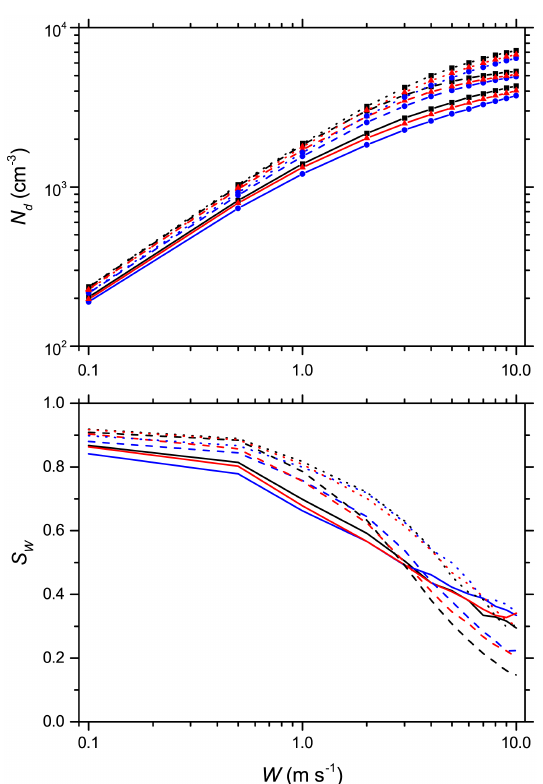
Figure 3. Number of particles activated (top) and sensitivity S W of N d to the updraft velocity W (bottom) for κ p the MP 5 , 1 (solid line), MP 1 , 5 (dashed line) and HP 5 , 5 (dotted line) case studies. Results for internal mixed Int population and exter- nally mixed populations Ext 1 and Ext 2 are in black, red and blue, respectively.